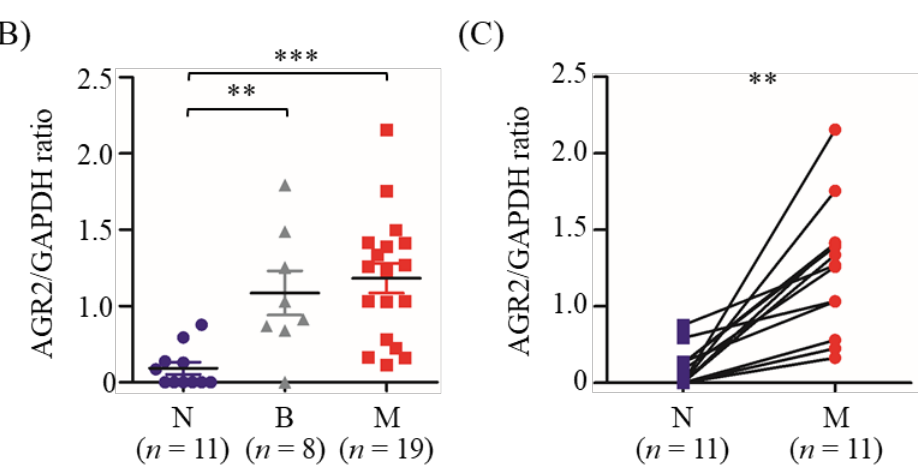
Figure 2. Elevated protein levels of AGR2 in canine MMT tissues compared with paired normal mammary tissues. Tissue homogenates (20 µ g proteins each sample) of MMT (denoted M), paired with benign mammary tumor (denoted B) and normal mammary gland tissues (denoted N) collected from the same patient, were analyzed by immunoblotting using an antibody specific to AGR2. GAPDH was used as an internal control. Representative results of nine cases (No. 1 to No. 9) were shown in ( A ). AGR2 protein levels in individual samples were determined by calculating the AGR2-to-GAPDH ratio. ( B ) Comparison of AGR2 protein levels between tissue types. Statistical significance was determined by Mann–Whitney U test. ( C ) Pairwise comparison of AGR2 protein levels between MMT and paired normal mammary gland tissues of the same patient. Lines represent individual patients. Statistical significance was determined by two-tailed paired t -test. ** p < 0.01; *** p < 0.001.